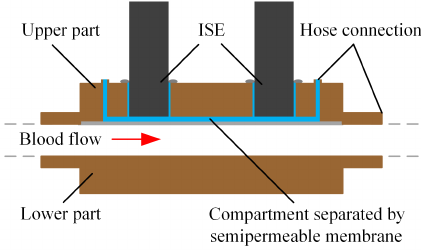
Figure 9. Schematic depiction of the cross section of the measuring